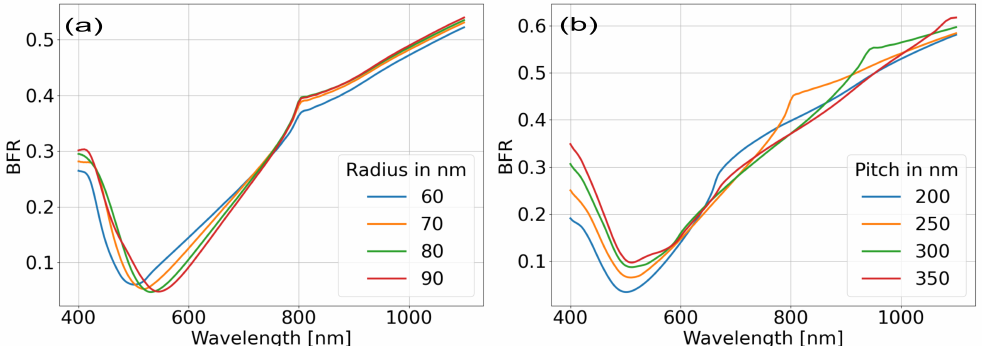
Figure 4. The effect on BFR of radius ( a ) and pitch ( b ) of the nanodisk array. Suppressed backward scattering can be observed at ∼ 550nm in both ( a , b ). Variations in radius and pitch show a small effect on the BFR minima